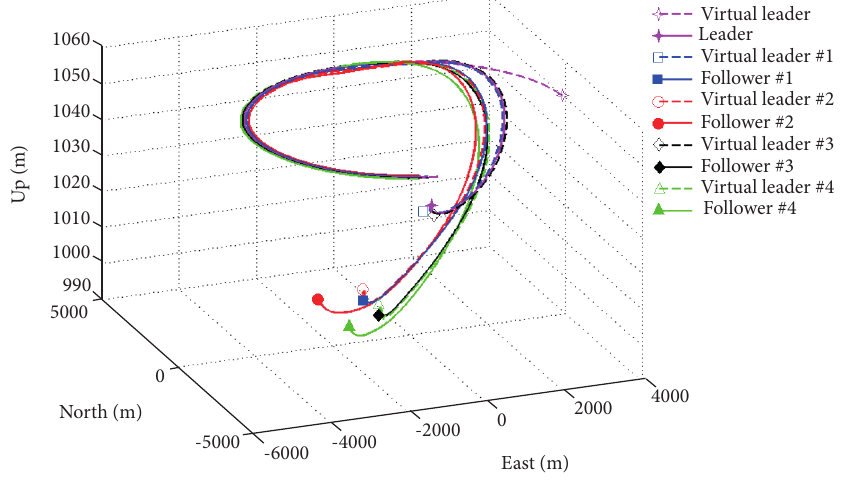
Figure 12. Leader and followers control surface deflection.